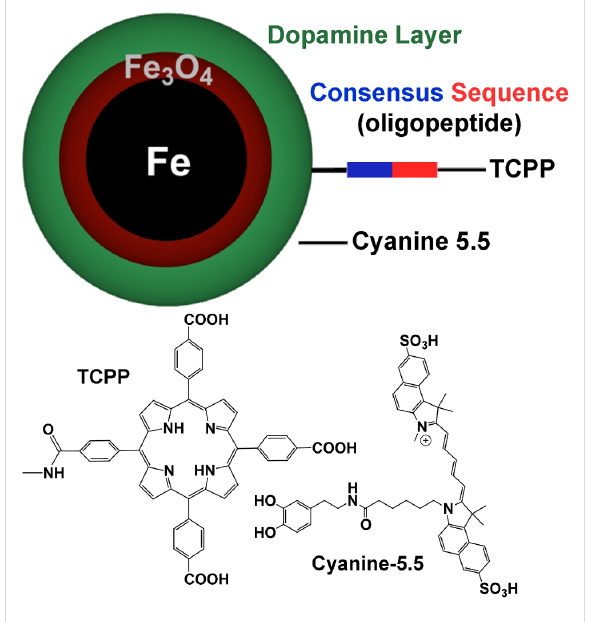
Figure 1: Nanosensors for in vitro protease detection. For each protease, a highly selective oligopeptide is used to tether tetrakis- carboxy-phenyl-porphyrin (TCPP) to the nanoparticle. Cyanine 5.5 is linked permanently to the Fe/Fe 3 O 4 nanoparticles. Figure 1 is repro- duced from [23] with